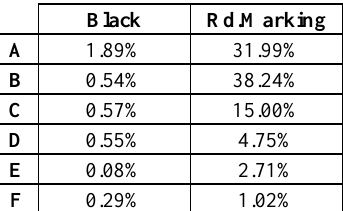
Table 5. Road Marking Misclassification Values